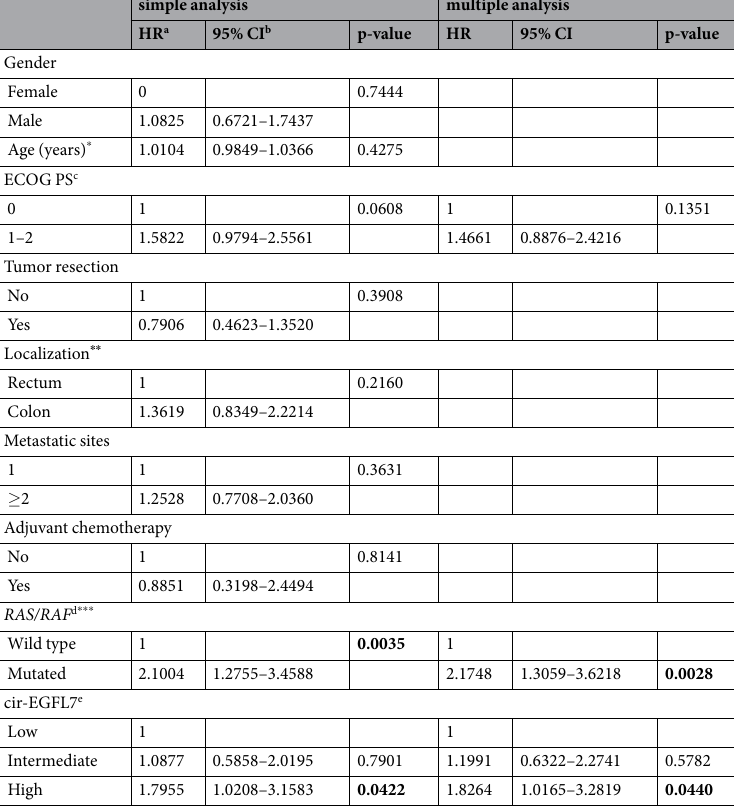
Table 2. Cox regression analysis, progression free survival (n = 84 in the multiple analysis). HR a , hazard ratio; CI b , confidence interval; ECOG PS c , Eastern Cooperative Oncology Group Performance Status; RAS/RAF d , KRAS, NRAS, and BRAF mutational status; cir-EGFL7 e , circulating epidermal growth factor-like domain 7. * Age is included in the analyses as a continuous parameter. ** The two patients with synchronous tumors were not included in the analyses. *** The four patients with unknown RAS/RAF mutational status were not included in the Cox regression analysis leading to N = 84 in the multiple